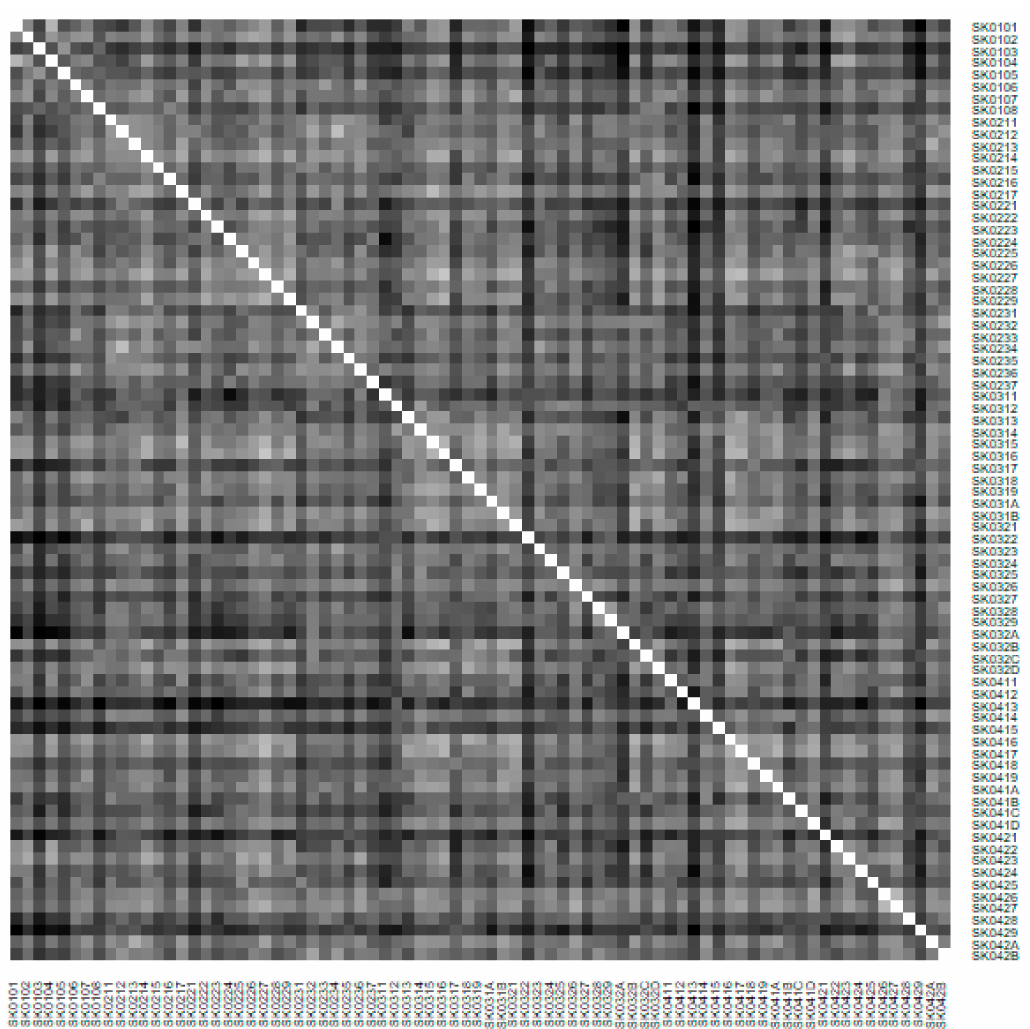
Figure 27. Preventable mortality heat map of the districts for the male sex in the whole explored period. Source: own elaboration by the